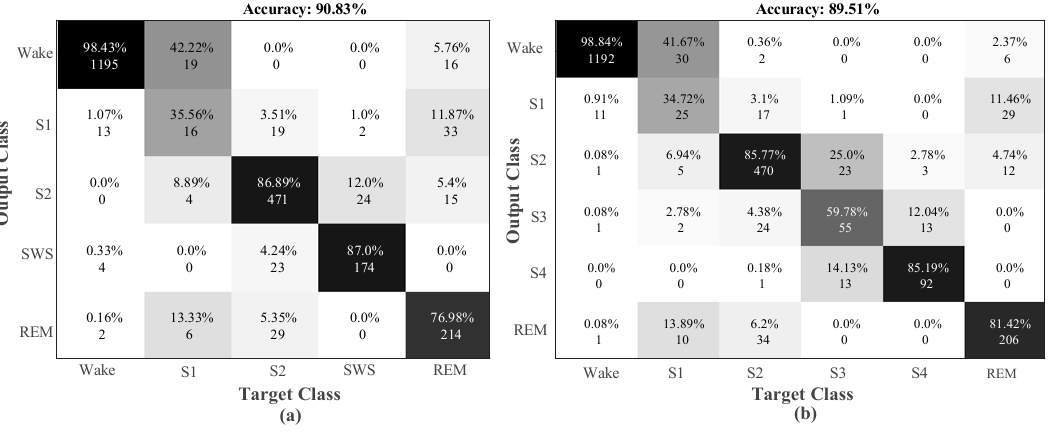
Figure 7. Confusion matrix obtained for single-channel EEG input signals of the sleep-edf data: ( a ) five-class test data and ( b ) six-class test data.